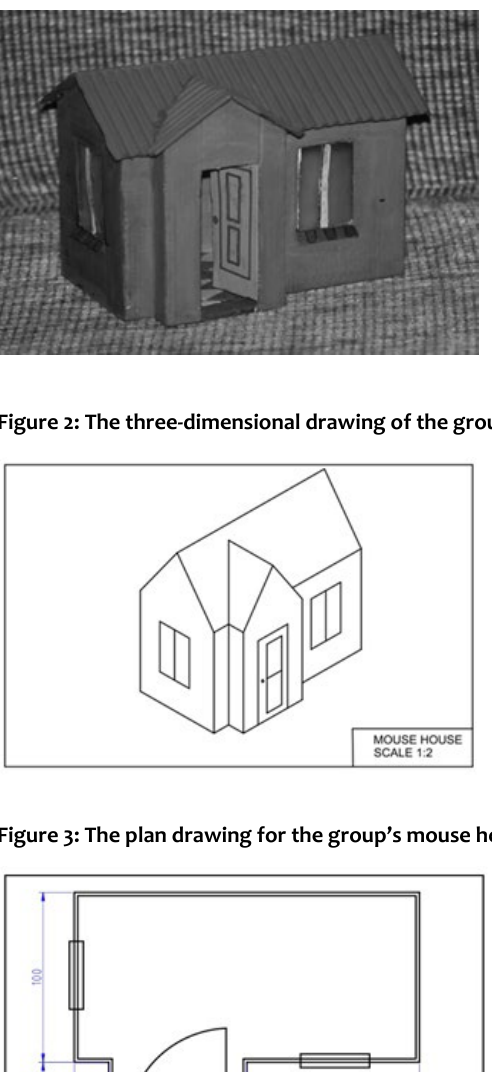
Figure 1: Photograph of one of the group-work-project mouse houses